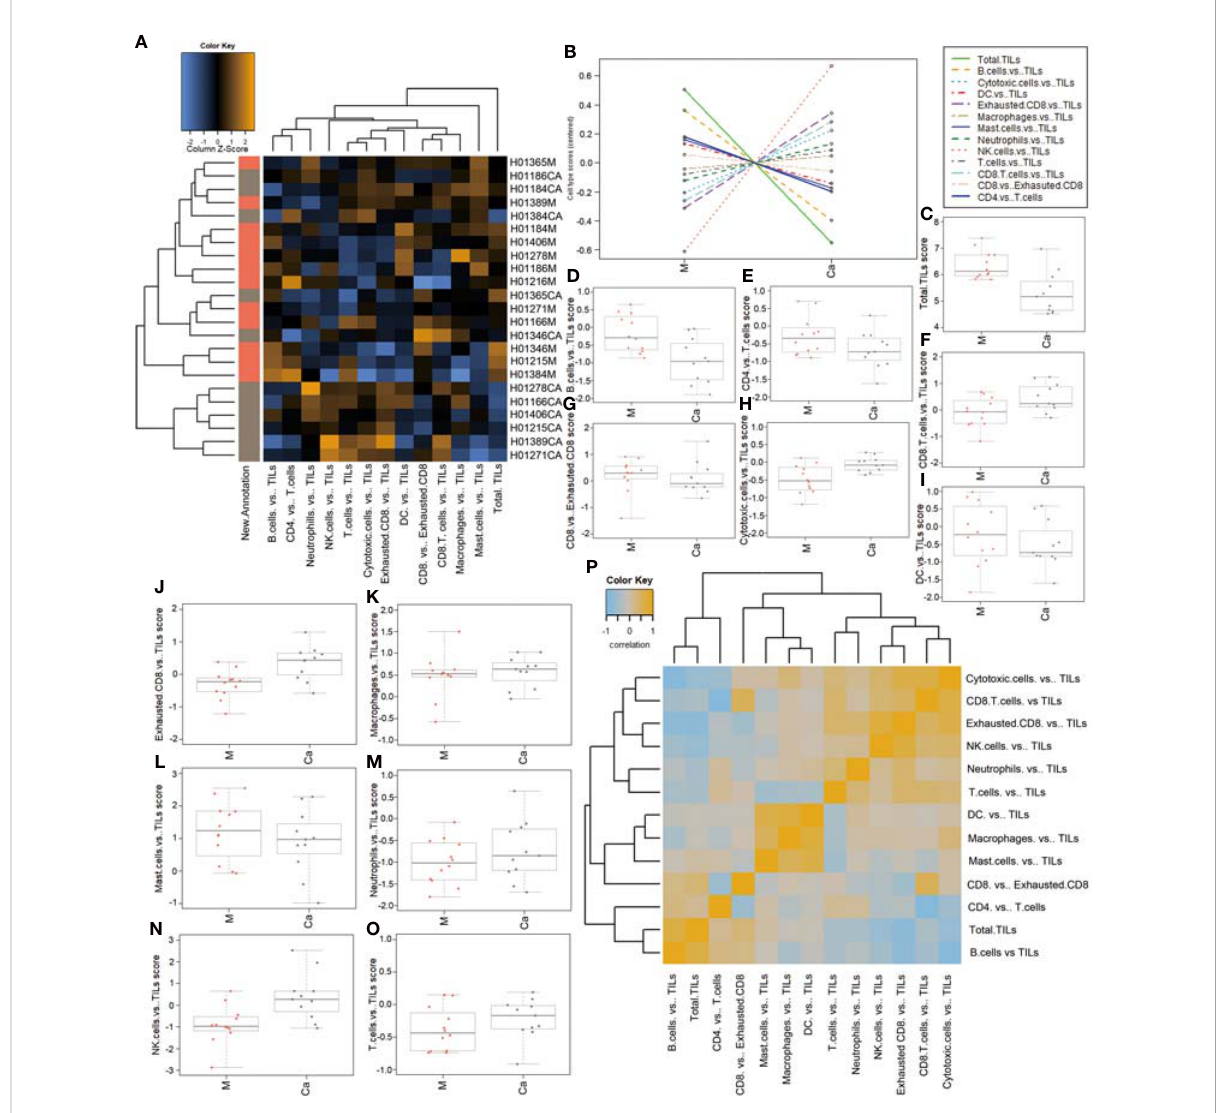
FIGURE 4 Correlation between immune response cells and immune in fi ltration in HSCC tissues and adjacent normal tissues. (A) Heatmap of relative cell type measurements. Orange indicates high abundance; blue indicates low abundance. (B) Relative cell type measurements vs. New.Annotation plots the relative cell type abundance measurements. (C) Each panel plots total TILs against another relative abundance measurements. Points are colored by New.Annotation. (D) Each panel plots B cells vs. TILs against another relative abundance measurements. Points are colored by New.Annotation. (E) Each panel plots CD4 cells vs. T cells against another relative abundance measurements. Points are colored by New.Annotation. (F) Each panel plots CD8 cells vs. TILs against another relative abundance measurements. Points are colored by New.Annotation. (G) Each panel plots CD8 vs. exhausted CD8 against another relative abundance measurements. Points are colored by New.Annotation. (H) Each panel plots cytotoxic cells vs. TILs against another relative abundance measurement. Points are colored by New.Annotation. (I) Each panel plots DC vs. TILs against another relative abundance measurements. Points are colored by New.Annotation. (J) Each panel plots exhausted CD8 vs. TILs against another relative abundance measurements. Points are colored by New.Annotation. (K) Each panel plots macrophages vs. TILs against another relative abundance measurements. Points are colored by New.Annotation. (L) Each panel plots mast cells vs. TILs against another relative abundance measurements. Points are colored by New.Annotation. (M) Each panel plots neutrophils vs. TILs against another relative abundance measurements. Points are colored by New.Annotation. (N) Each panel plots NK cells vs. TILs against another relative abundance measurements. Points are colored by New.Annotation. (O) Each panel plots T cells vs. TILs against another relative abundance measurements. Points are colored by New.Annotation. (P) Heatmap of the correlation matrix of relative cell type measurements. Heatmap showing the correlation matrix of relative cell abundance. Orange and blue indicate positive and negative correlations, respectively. Ordinate: log 2 TPM (Ca: HSCC tissues M: adjacent normal